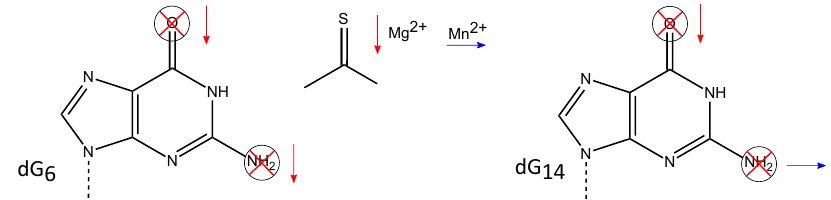
Figure 5. Proposed important exocyclic groups within the 10-23 DNAzyme. The 6-keto group as well as the 2-amino group of both dG 6 and dG 14 are of functional imporatance for the DNAzyme activity. Deletion of either the 6-keto group or the 2-amino group of dG 6 as well as the deletion of the 6-keto group of dG 14 lead to an dramatic decrease in catalytic acitivity of the 10-23 DNAzyme as indicated by the red arrows. Substituting the oxygen atom of the 6-keto group in dG 6 by a sulfur atom leads to a DNAzyme with significantly reduced cleavage activity in the presence of Mg 2 + (indicated by a red arrow), but the activity can be rescued in the presence of Mn 2 + (indicated by a blue arrow). In addition, deletion of the dG 14 does not significantly affect the acitivity of the